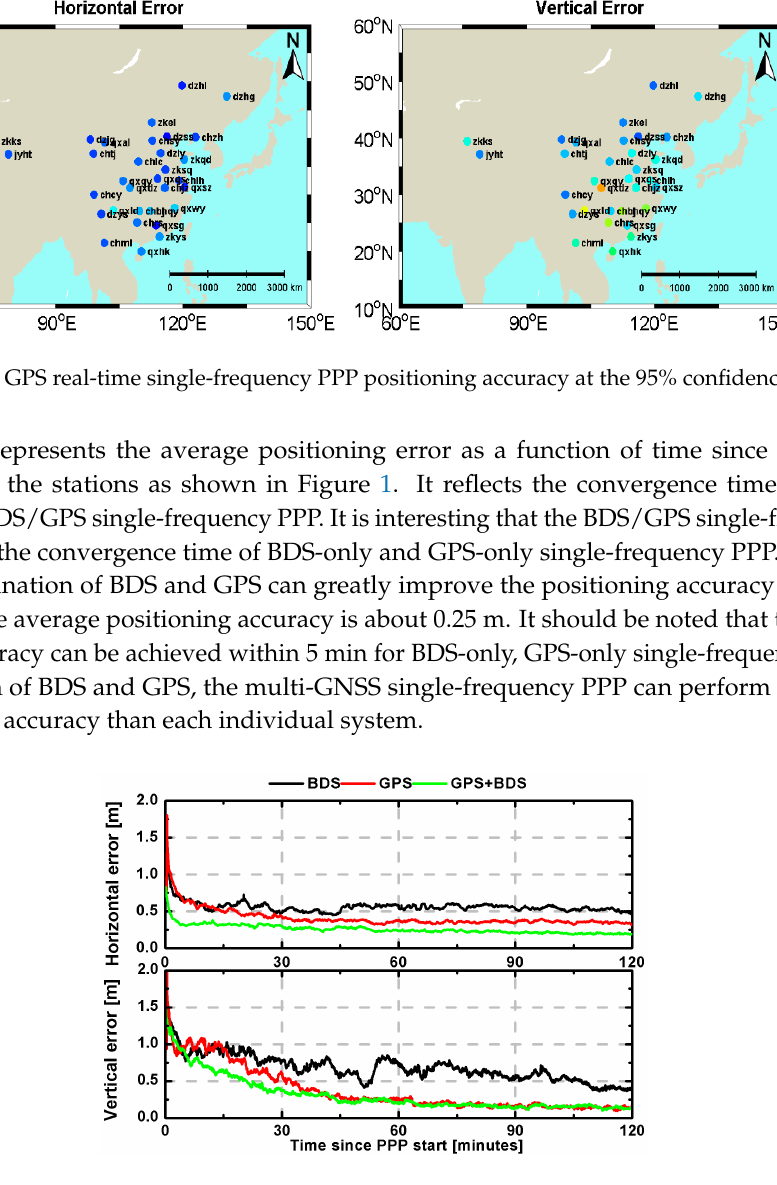
Figure 12. BDS real-time single-frequency PPP positioning accuracy at the 95% confidence level.